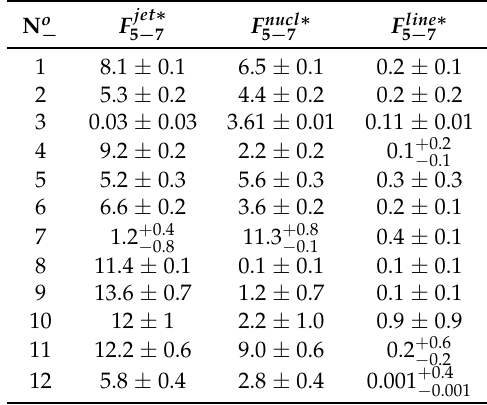
Table 3. 5–7 keV fluxes for various model components. First column: observational period; second column: jet flux in 5–7 keV energy range; third column: nuclear flux in 5–7 keV energy range; fourth column: Fe-K α emission line flux in 5–7 keV energy range. N o